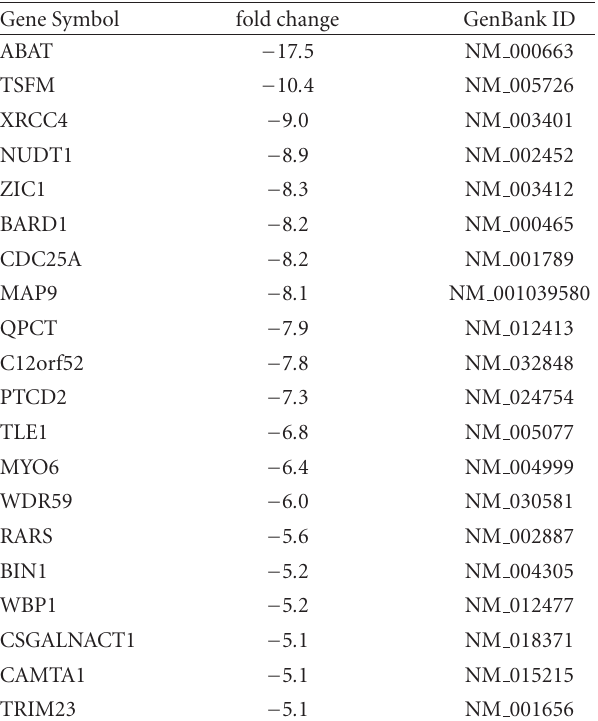
Table 4: Microarray Analysis of A375(DRO) cells after TZD/ rexinoid combination treatment—2-fold down regulated with ROSI alone.